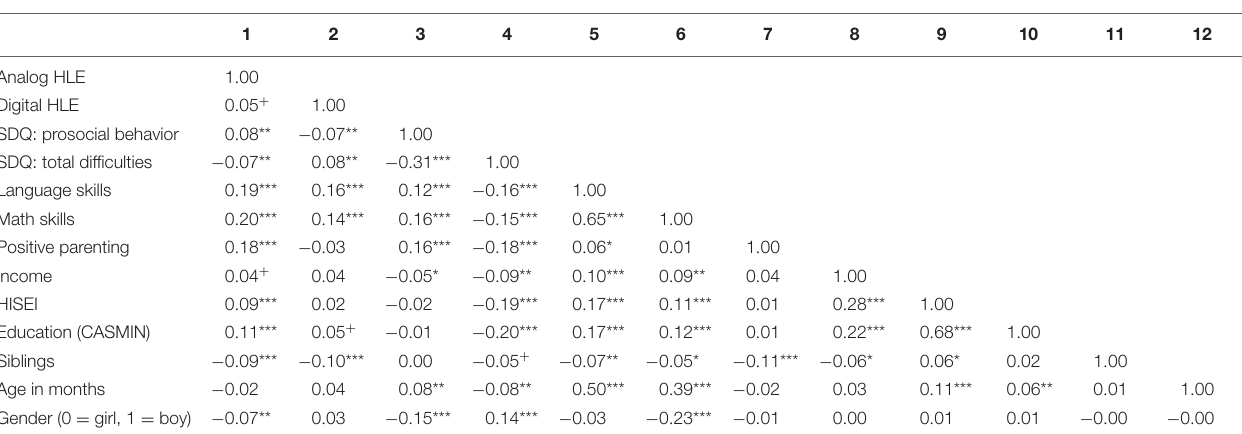
TABLE 4 | Bivariate correlations of the study variables in the preschooler age